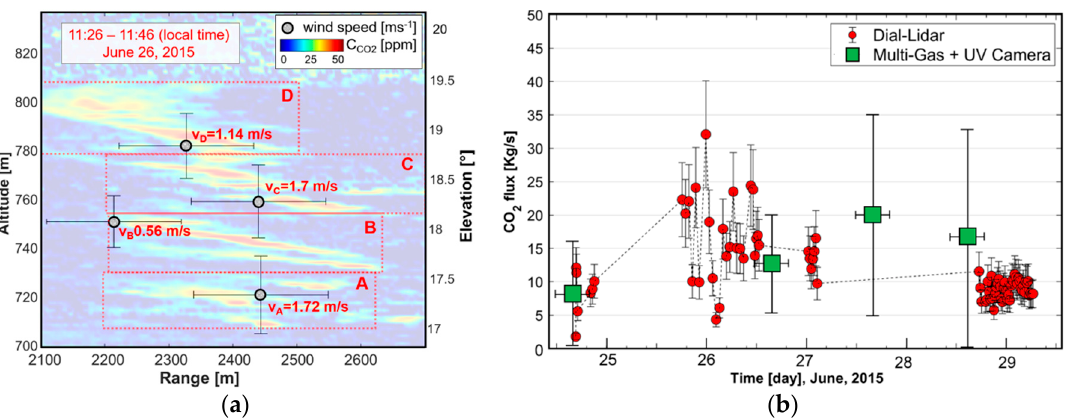
Figure 4. ( a ) In-plume CO 2 concentration map acquired on 26 June 2015 at Stromboli. Carbon dioxide concentration varies as a function of increasing altitude (on the left of the map) and elevation (on the right of the map). The superimposed grey points represent the vertical wind profile retrieved by BILLI in the same dataset. Here, the mean value of the wind velocity was found about 1.3 m / s. The x-axis error bar is the weighted average standard uncertainty of wind velocity, equal to 0.52 m / s. Instead, the error bar on the y-axis represents the altitude halfwidth between adjacent regions (A, B, C, and D) [40]). This figure has been obtained by combining Figure 4 and Figure 8 reported in [40]. ( b ) Time-series of CO 2 fluxes from Stromboli volcano from 24 to 29 June 2015, rearranged from Figure 5 reported in [41]. The BILLI based fluxes (red circles) were obtained using the procedure detailed here [39,41]. (from Multi-GAS) by the SO 2 flux (from UV cameras) are also presented (green squares)